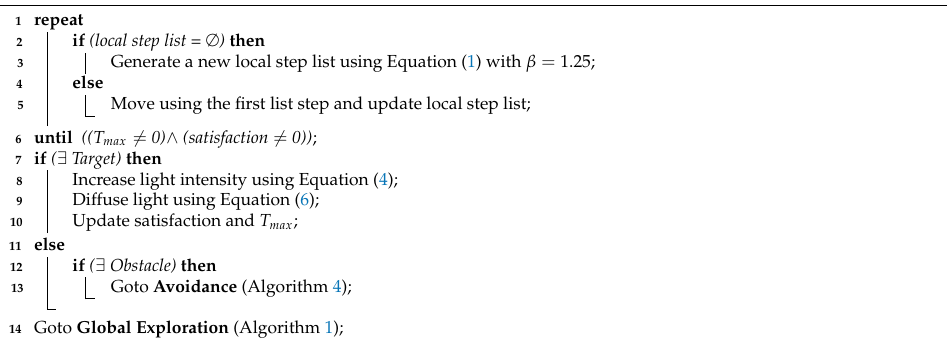
Algorithm 2: Local Exploration